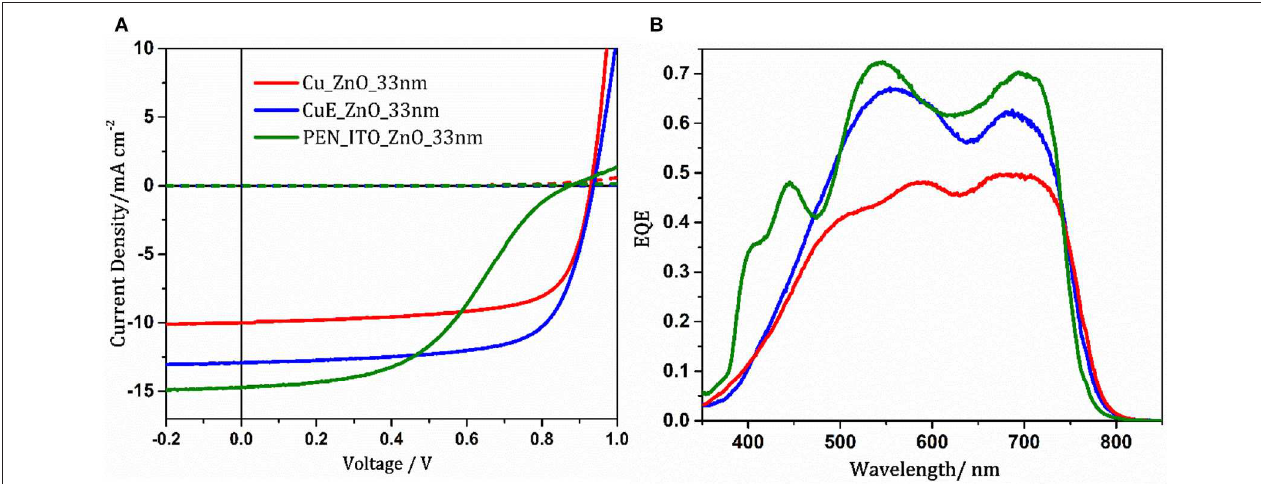
FIGURE 5 | (A) Representative current density—voltage characteristics recorded under one sun simulated solar illumination (100 mW cm − 2 ; AM 1.5G) (solid lines) and in the dark (dotted lines) for devices with the architecture: Transparent electrode/ZnO (33nm)/PCE12— m -ITIC/MoO z (10nm)/Ag (85nm) and (B) EQE under same conditions for devices with Cu (red) and CuE (blue) and ITO (green) electrodes.